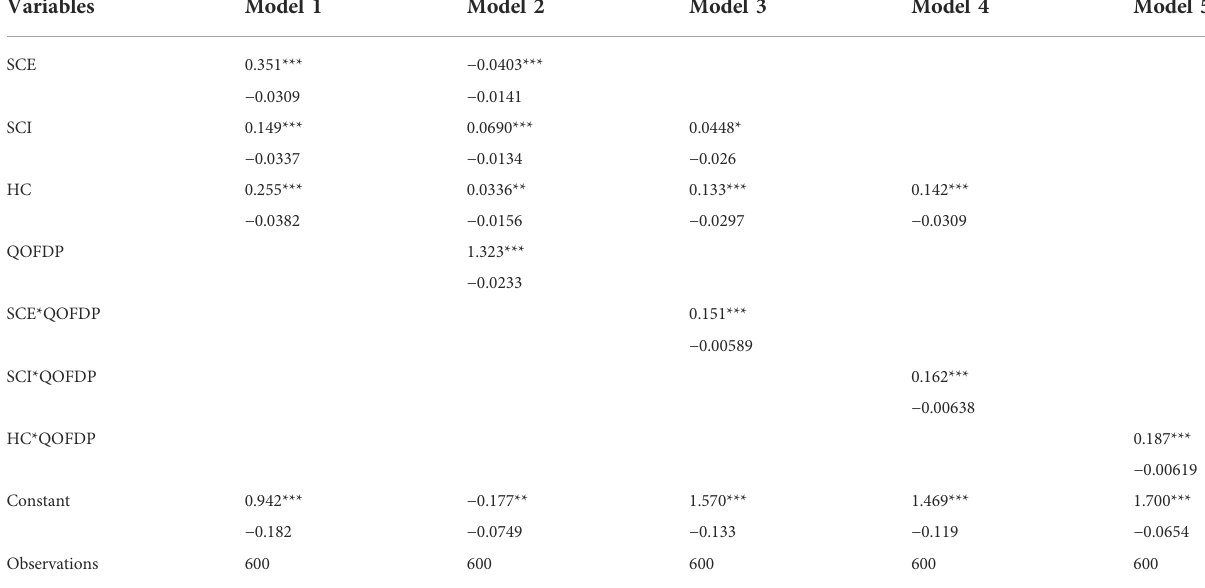
TABLE 7 Moderator analysis.